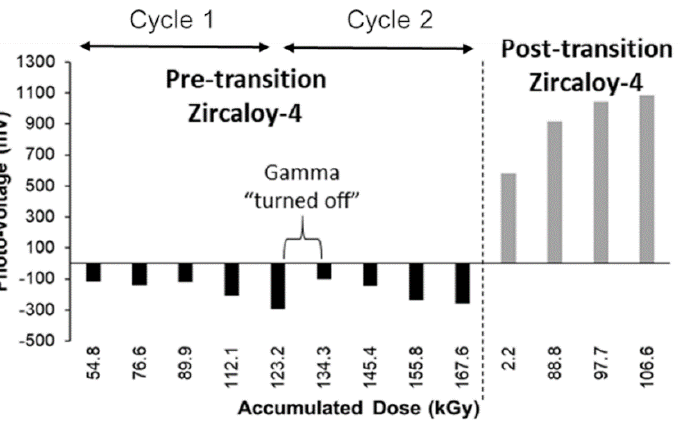
Figure 11. Photo-voltage response of pre-transition and post-transition Zircaloy-4 under gamma irradiation at 150 °C.